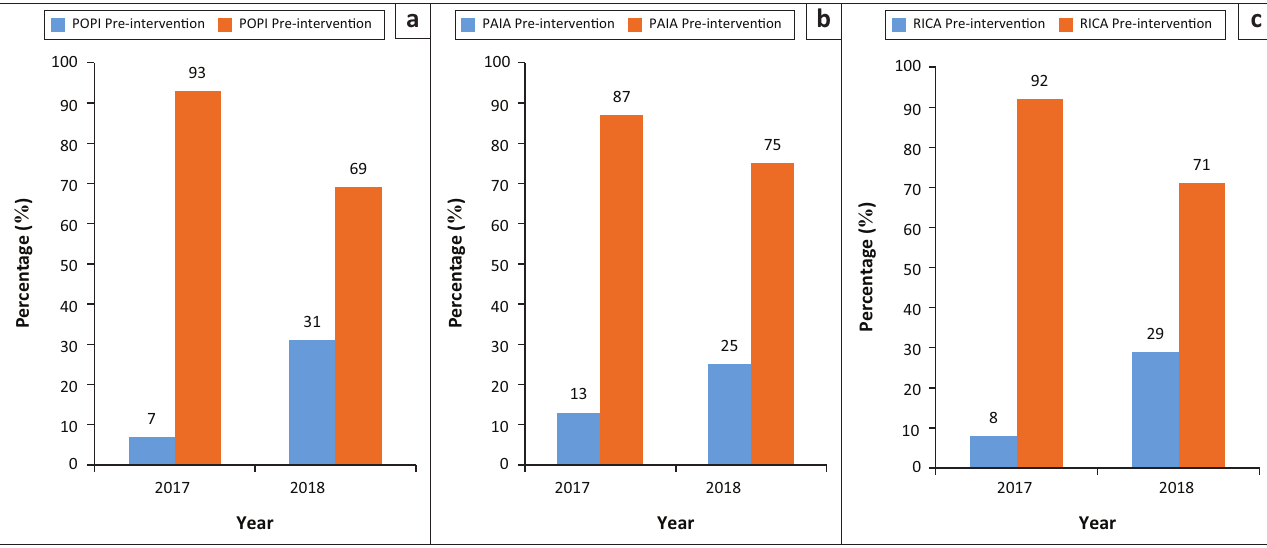
FIGURE 4: Pre-intervention response to acronyms Protection of Personal Information, Promotion of Access to Information Act and Regulation of Interception of Communication Act for the years 2017 and